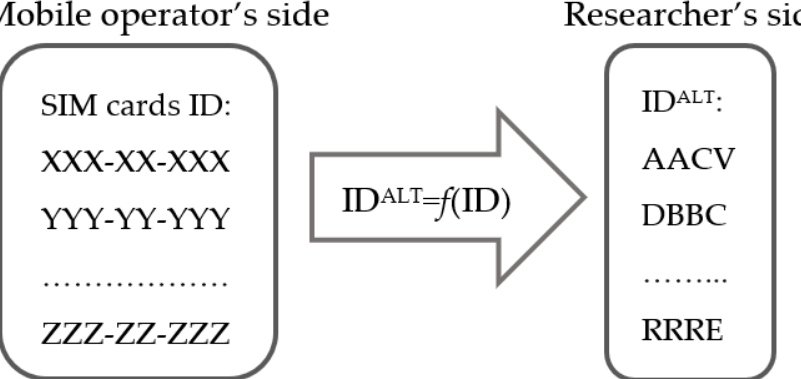
Figure 3. Depersonalization of cellular data by implementing artificial ID. Source: compiled by the author.